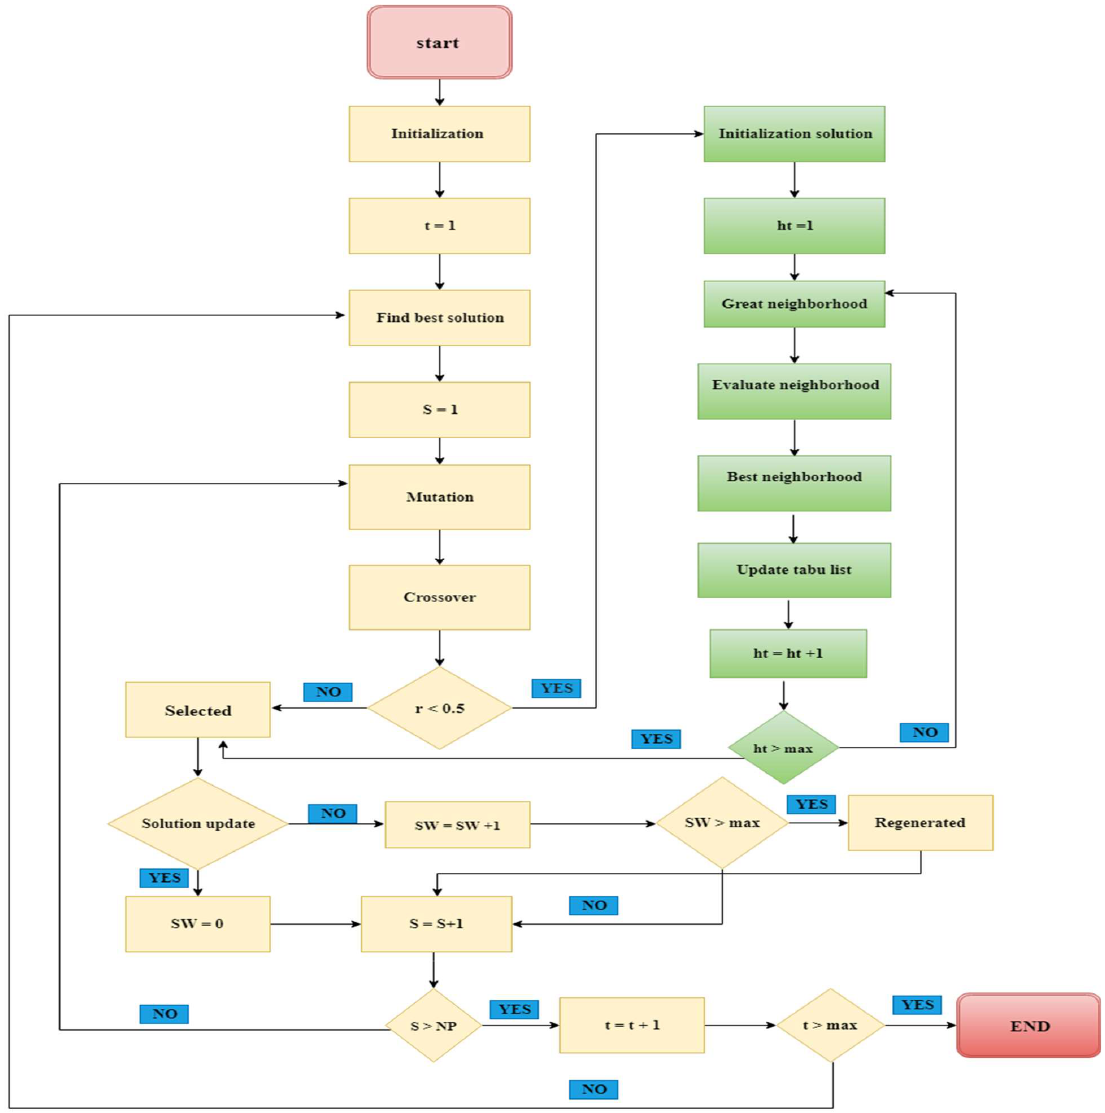
Fig. 2. Flowchart of HDDETS